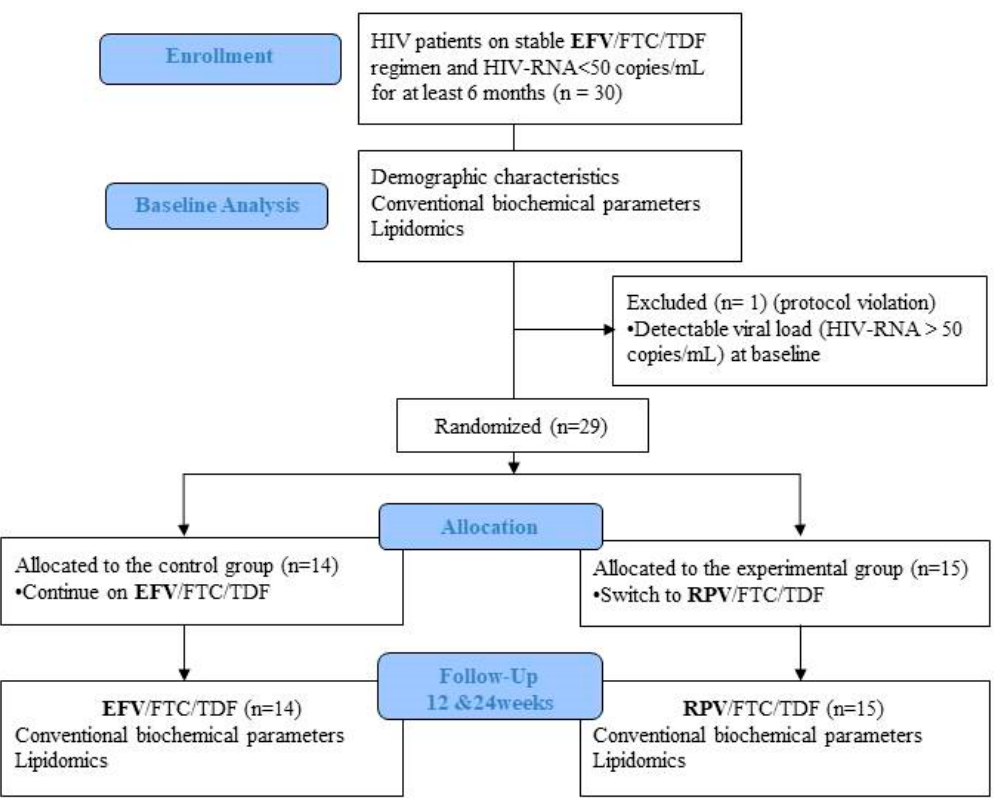
Figure 1. Flow diagram of participants throughout the course of the study. Abbreviations: EFV, Efavirenz; FTC, Emtricitabine; TDF, Tenofovir Disoproxil Fumarate; RPV, Rilpivirine.